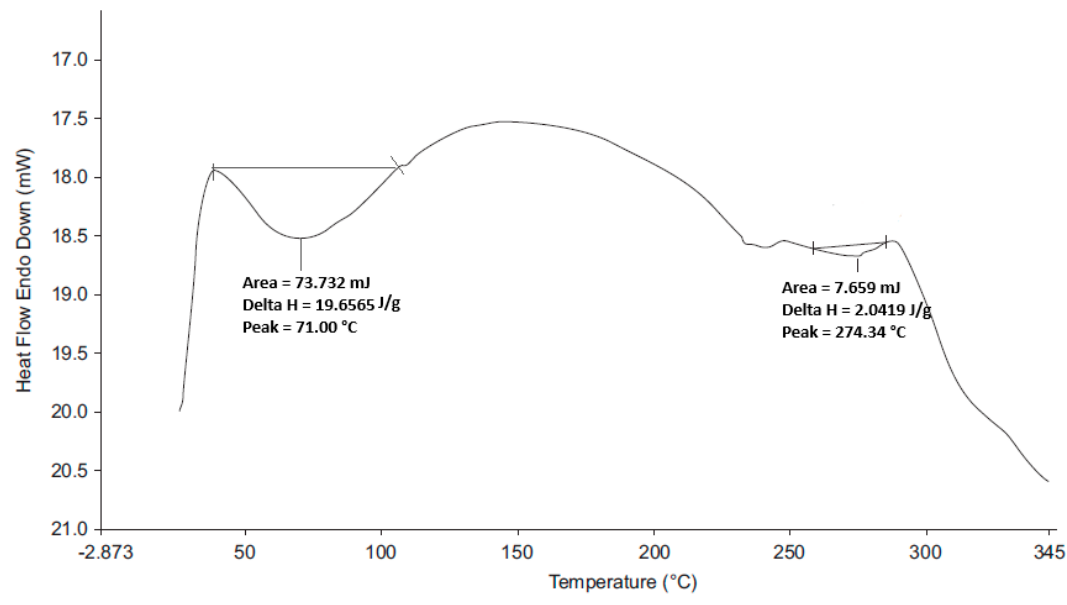
Figure 7. Differential scanning calorimetry (DSC) thermogram generated for HCTZ and 1:1 mixtures of HCTZ and potential excipients.